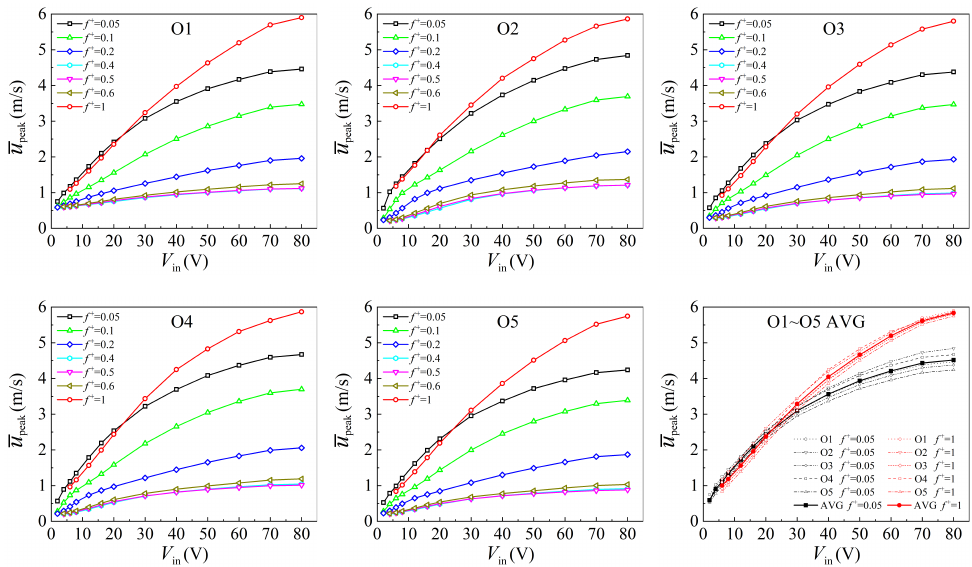
Figure 15. Parameter spaces of synthetic jets at orifices O1 ∼ O5. The normal distance to the injection plane was y o = 0.5mm, y o / d o =